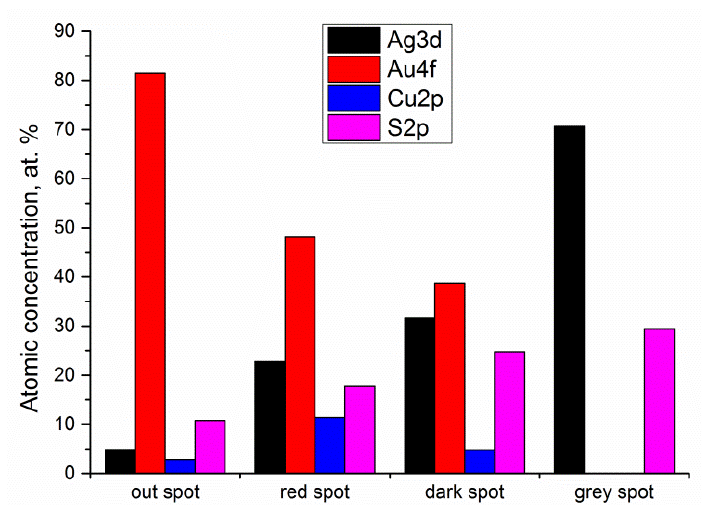
Figure 5. XPS elemental quantification of the different spots on the gold coin.